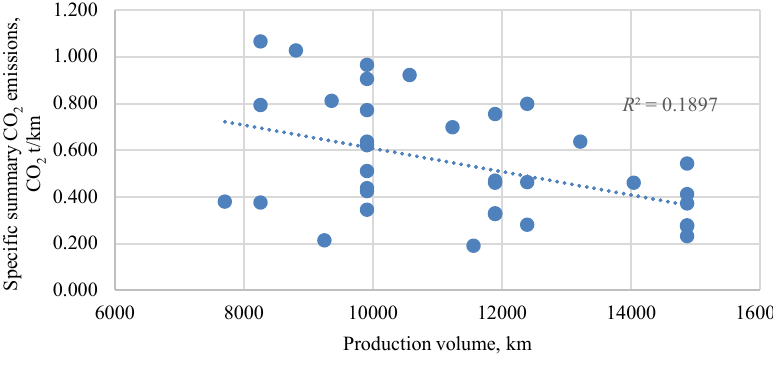
Fig. 6. Linear regression analysis of specific total CO 2 emissions and production